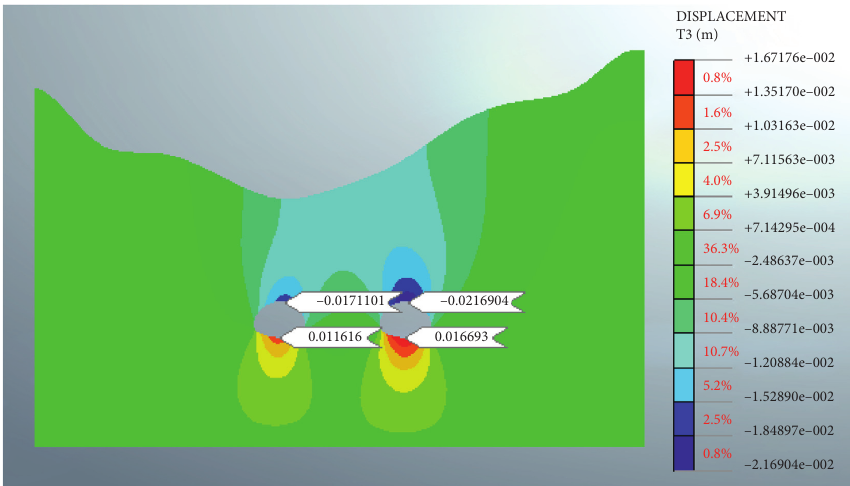
Figure 27: Vertical displacement distribution of surrounding rocks by three-step